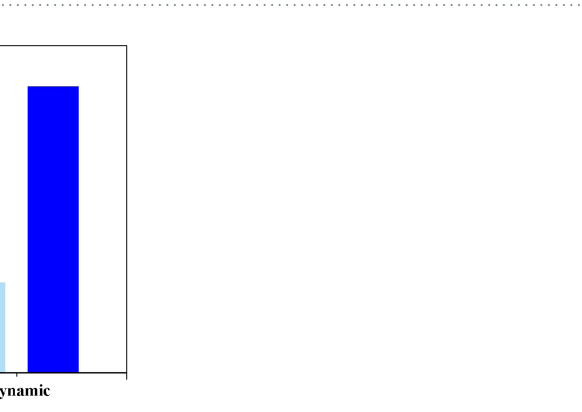
Figure 2. Schematic illustration of ( a ) dynamic state and ( b ) static state of vacuum flash reduction-inert gas condensation.